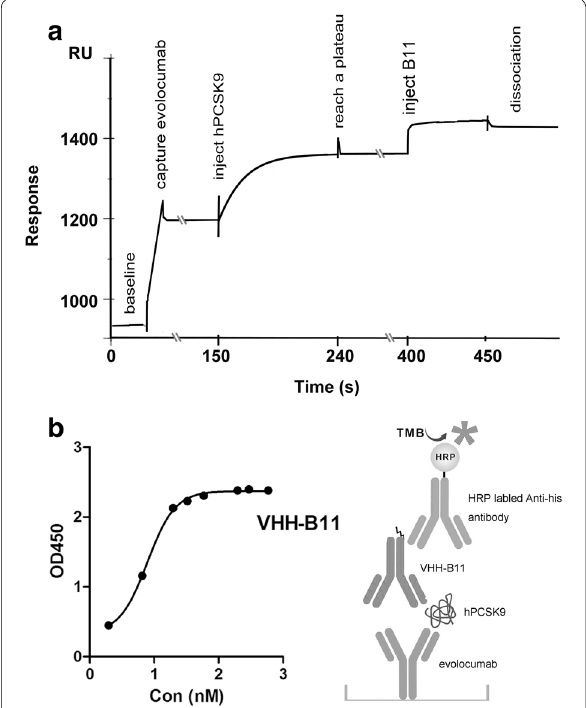
Fig. 4 The epitope binning assay by SPR and ELISA. a The epitope binning assay of the VHH-B11 was performed against the approved evolocumab by SPR (Protein A chip). The horizontal axis represents the timeline. The vertical axis represents the relative response unit. The curve consists of four processes: baseline; capture evolocumab; injecting PCSK9 (binding and dissociation); injecting VHH-B11 (binding and dissociation). b The dual antibody sandwich ELISA method between VHH-B11 and the approved evolocumab (coated on the plate, as shown in the schematic diagram). The horizontal axis represents different dilution concentrations of the VHH-B11. The vertical axis represents the OD450 value